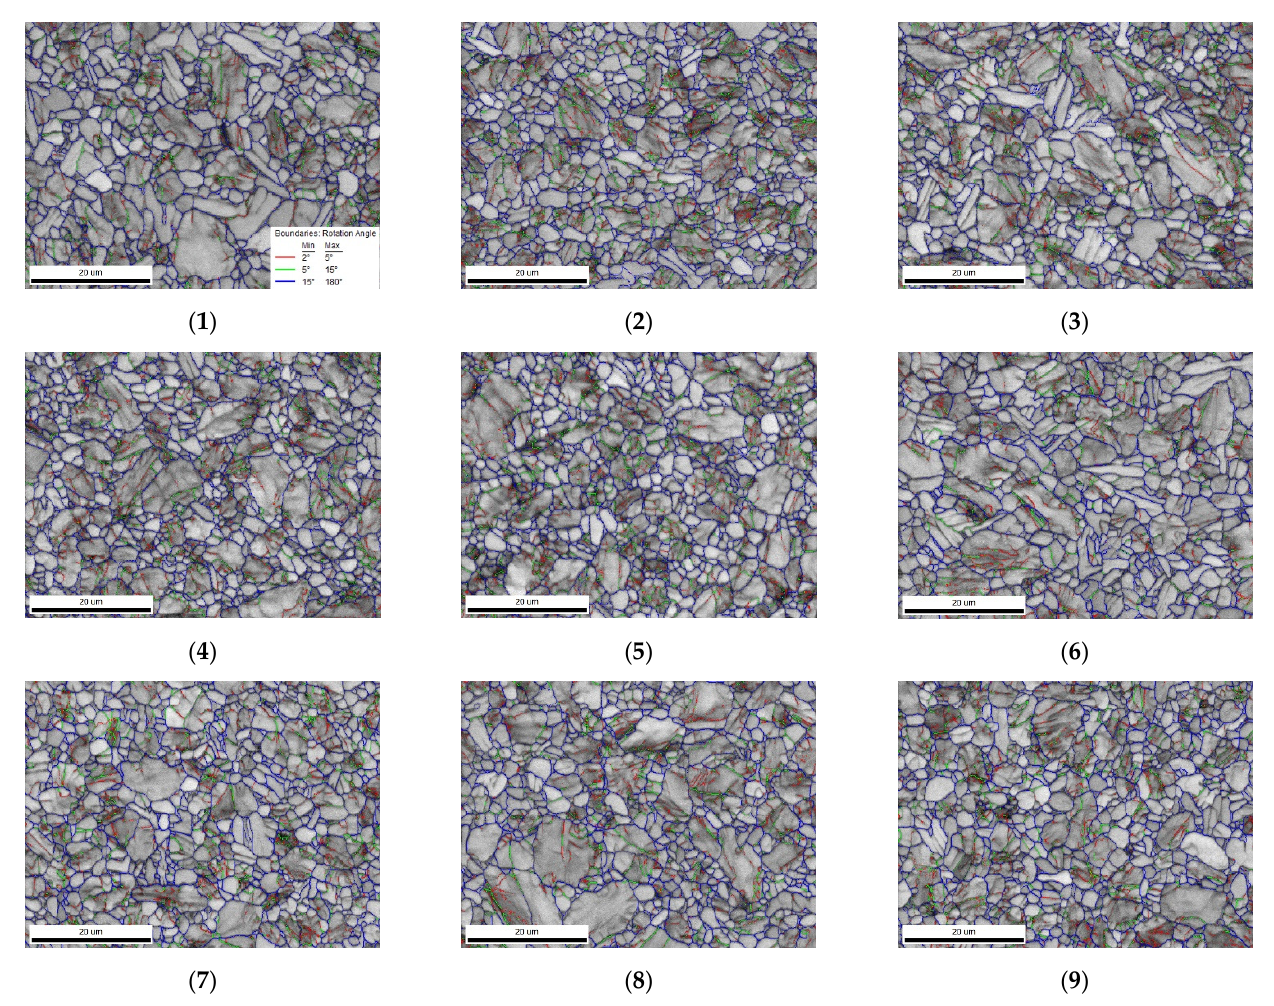
Figure 11. The grain boundary distribution maps of Ti-6Al-4V under different milling parameters.